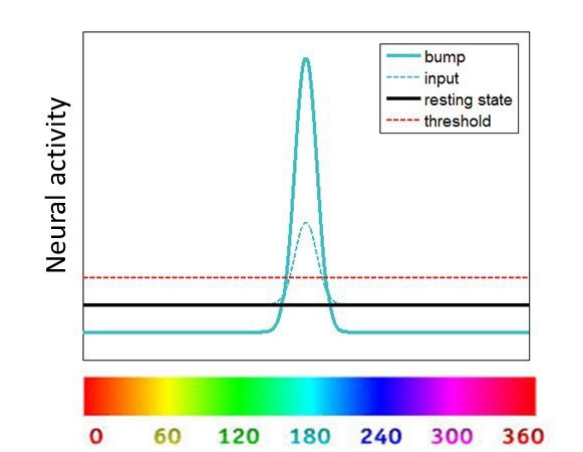
Figure 1. Stable bump triggered by a single color stimulus